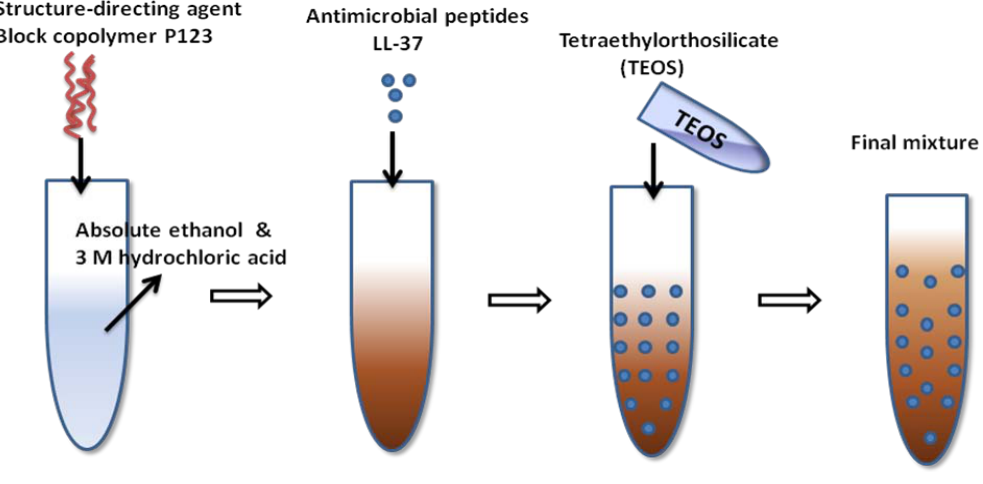
Figure 6. Schematic map of the incorporation of LL-37 into mesoporous silica films by one-pot EISA